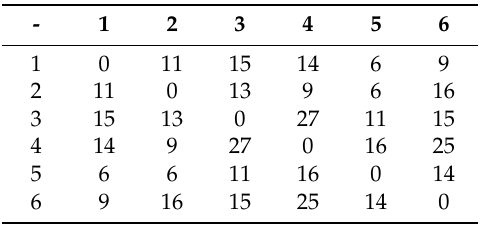
Table 3. The raveling times between fields.